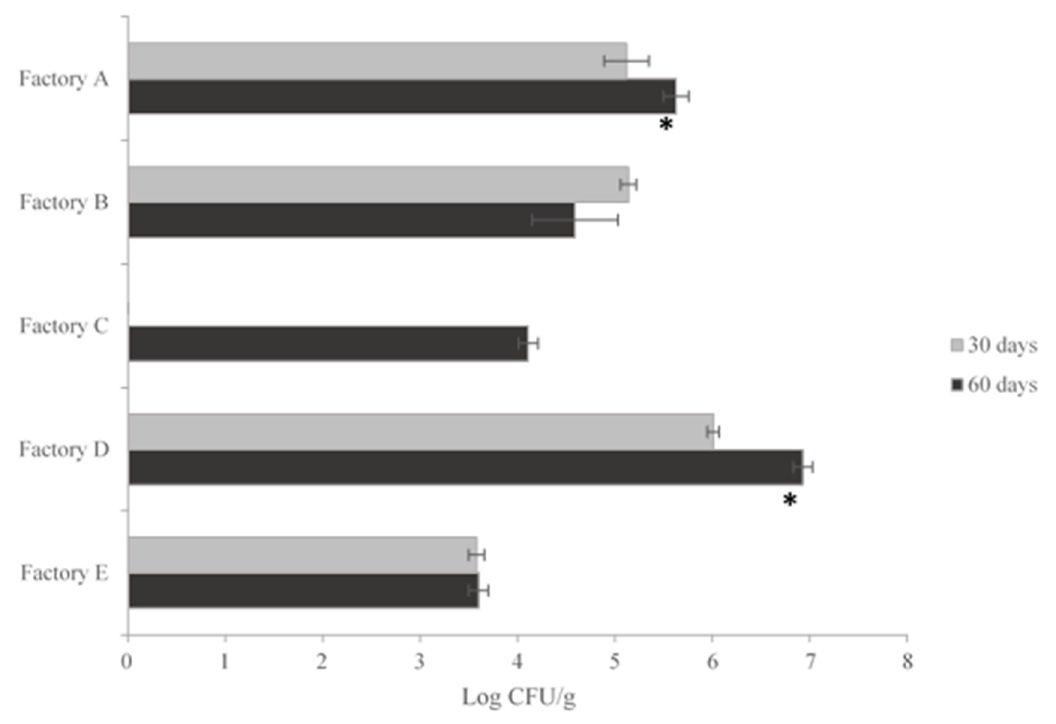
Figure 1. Yeast counts (log CFU / g) in pork and game meat fermented cured sausages at di ff erent ripening times. The * indicates significant di ff erences, based on the Student’s T-test, ( p ≤ 0.05) between cell counts at di ff erent curing times.